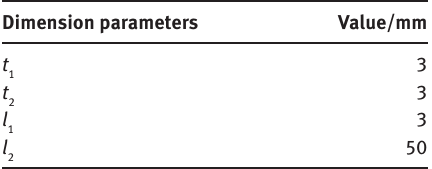
Table 2: Dimensions for the AGS composite plate.